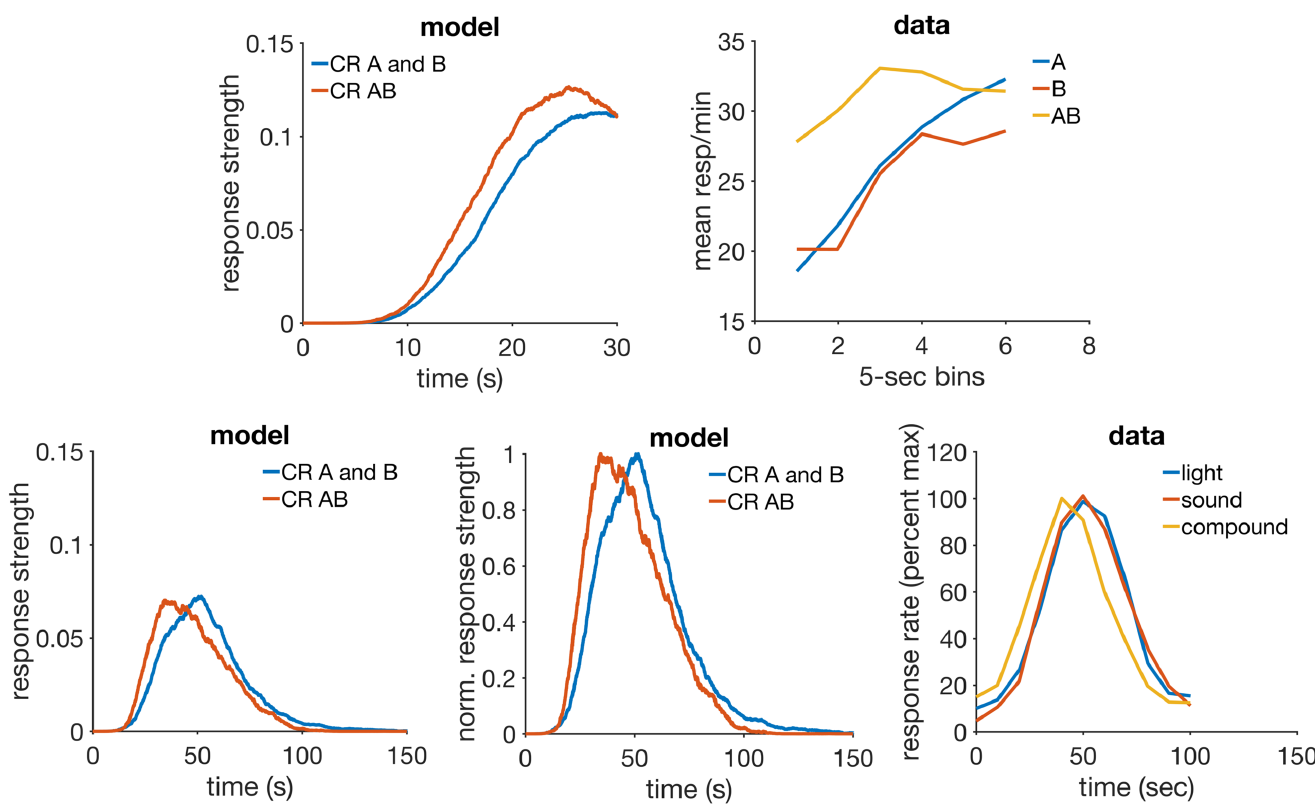
Fig 10. Disinhibition of delay and compound peak procedure. Top row: simulation(left) and data (right) of disinhibitionof delay. Bottom row: simulation(left and middle) and data (right) of a compoundpeak procedure.The middlepanel is a normalized (proportion of maximum response strength) version of the left panel. Data plot redrawn from Figure 13 in [44]. Model parameters: m = 0.25, θ = 1, σ = 0.18, α t = 0.75, α V = 0.1, H = 5.